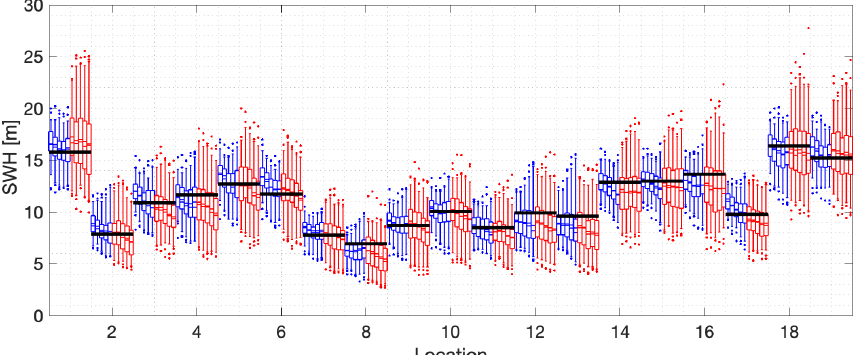
Figure 8. The 500-year return value for SWH estimated using probability-weighted moments for the 100m depth contour. The x axis gives the reference numbers of the 19 locations on the contour. Briefly, for each location, blue and red box–whiskers summarize the estimated return value from STM-E and single-location analysis respectively; see caption of Fig. 6 for other details. The black horizontal lines for each location correspond to the empirical estimate of the return value obtained directly from the full synthetic cyclone data for each